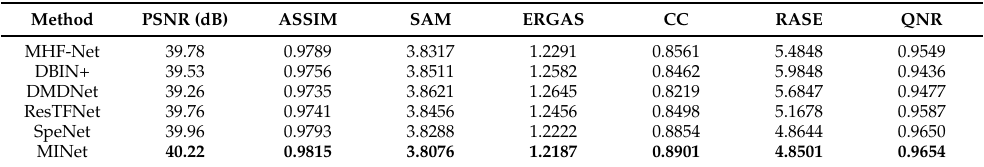
Table 4. Quantitative performance comparison with the investigated methods on the NCALM dataset. The best results are shown in